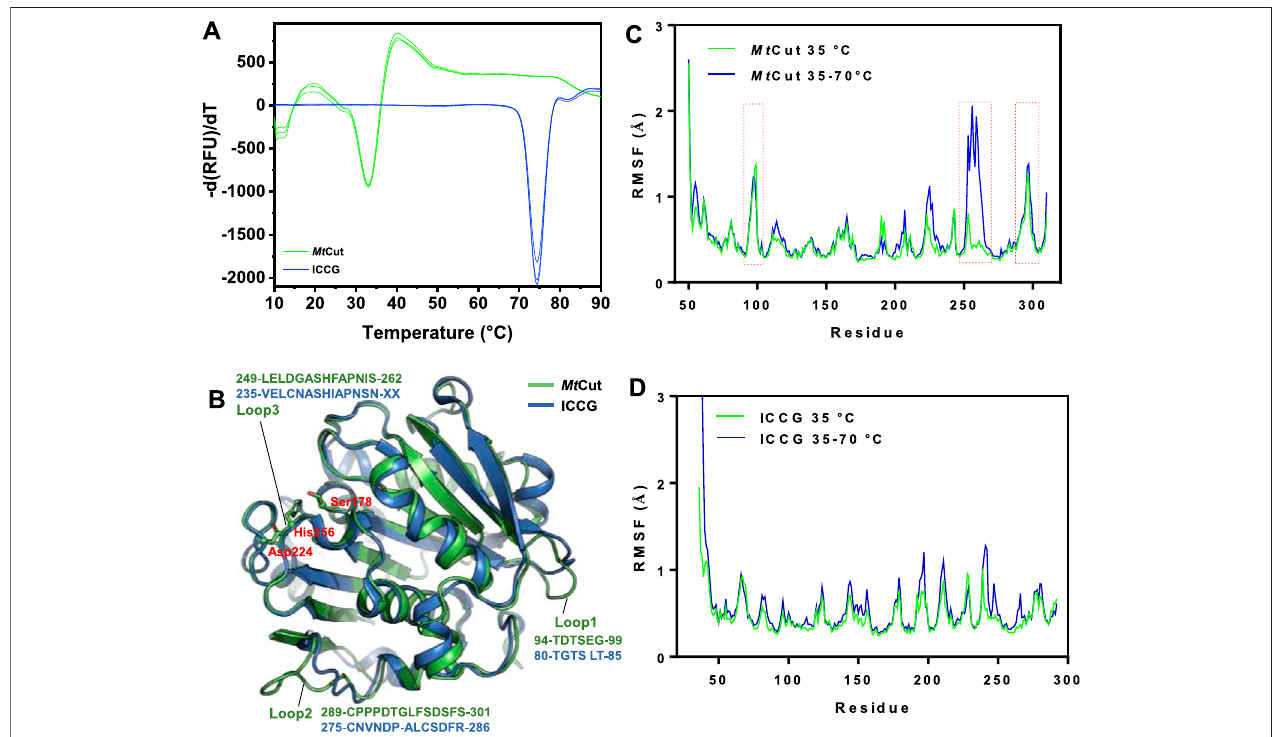
FIGURE5| Structural features associatedwithtemperature adaptation. (A) Comparing Mt Cutand ICCG meltingtemperature curves. (B) Structures of Mt Cutand ICCG (PDB entry: 6THT). The catalytic triad (Ser178, Asp224, and His256) is represented as a stick model. Root mean square fl uctuations (RMSF) (angstroms) of C α atoms of Mt Cut (C) and ICCG (D) structures at different temperatures. The 100 ns simulation trajectories at 35 ° C and heating from 35 to 70 ° C for each system were superposed and then used to calculate the